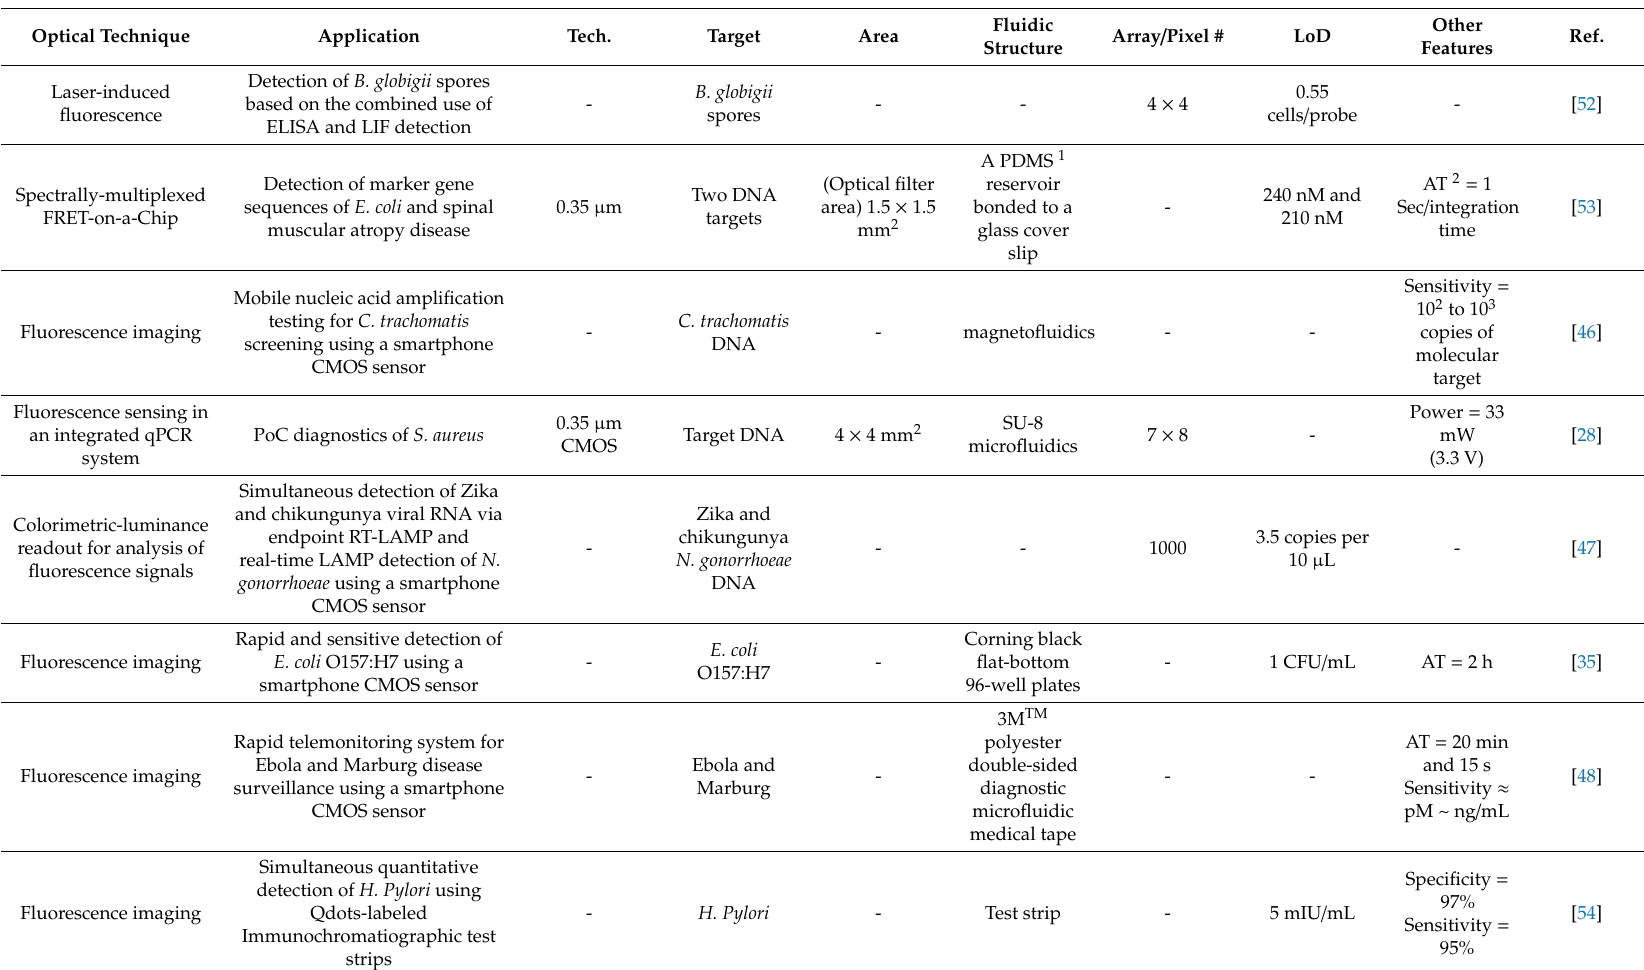
Table 3. CMOS-based optical biosensors reported for the diagnosis of various infectious